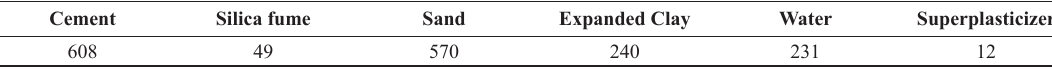
Table 1. Composition of the concrete mixture used in the study (kg/m 3 ). Cement